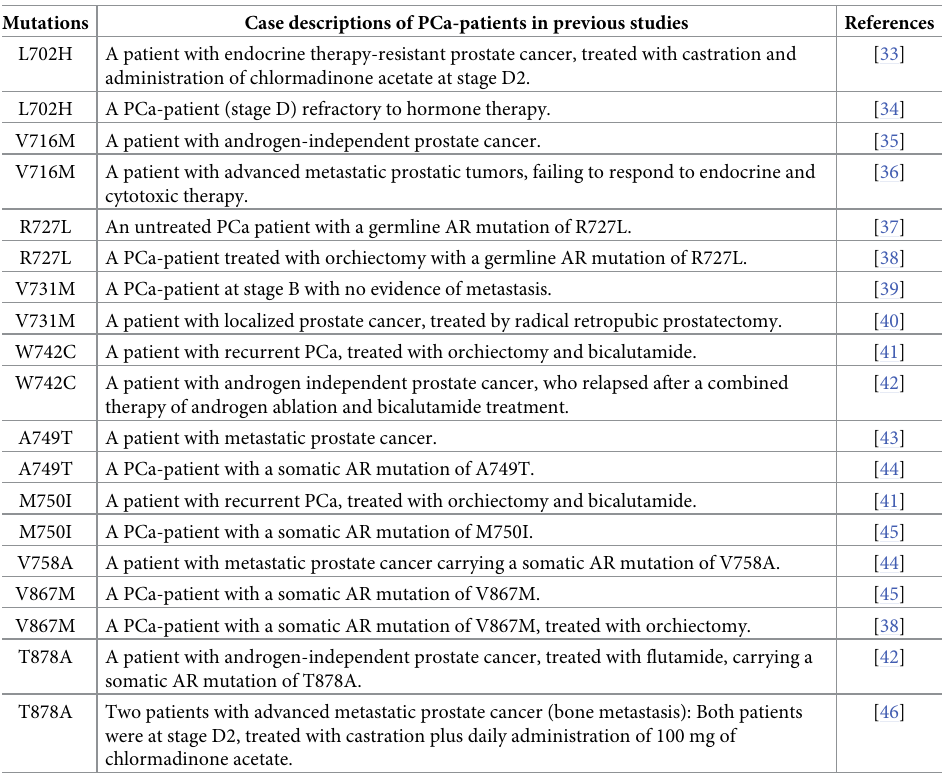
Table 1. Summary of clinical cases related to indicated AR mutations.